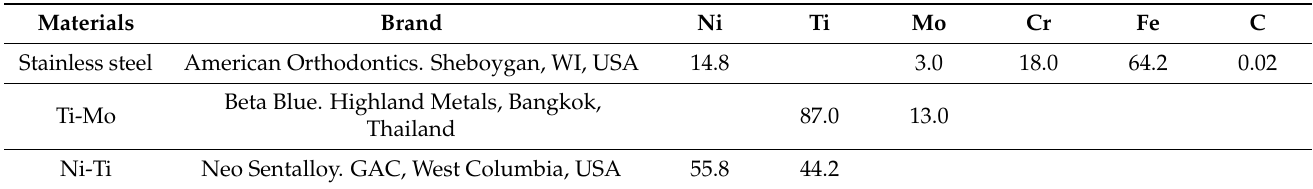
Table 1. Chemical compositions of the orthodontic archwires studied (% of